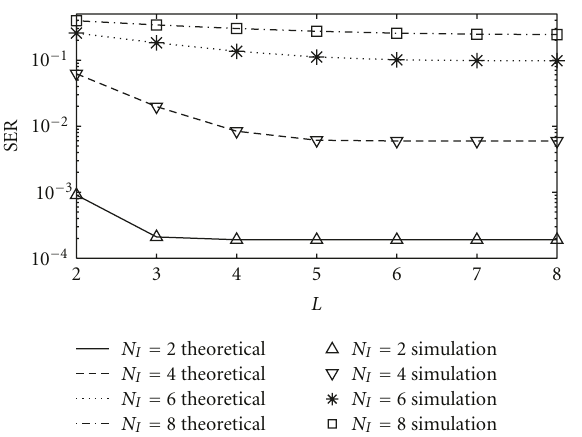
Figure 6: SER versus SNR with di ff erent kinds of modulation when L = 4, K =